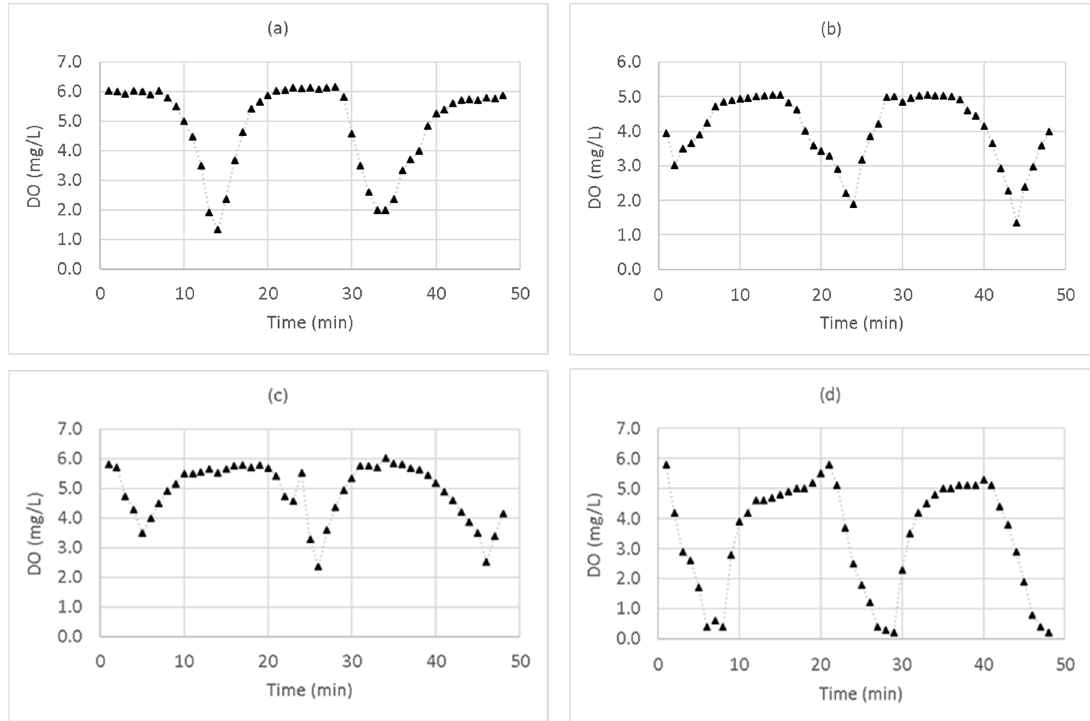
Figure 5. DO concentration variation in the HyVAB for Trial 1: ( a ) DO profile on the 237th day, ( b ) DO profile on the 241st day, ( c ) DO profile on the 247th day, and ( d ) DO profile on the 251st day.